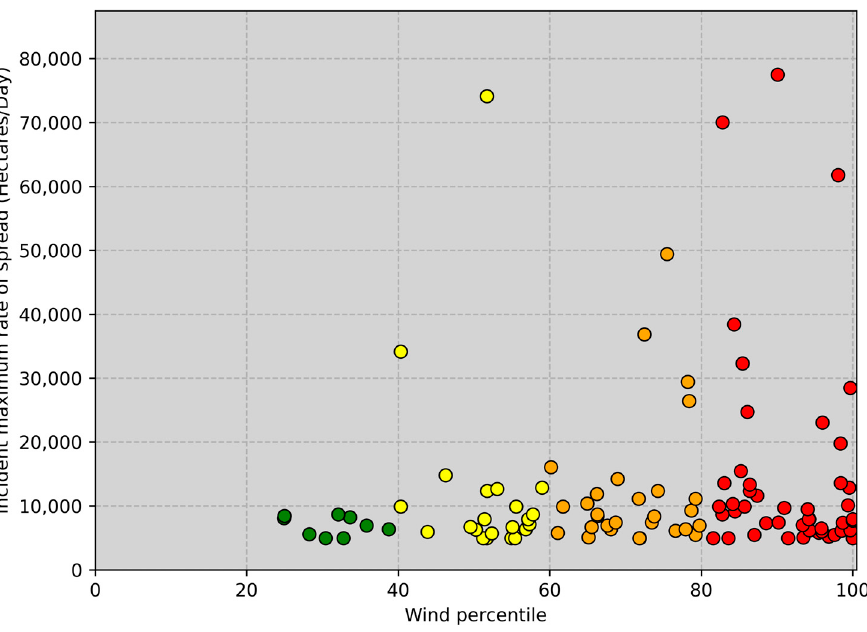
Figure 4. Wind speed percentiles for large incidents exceeding the statewide ROS breakpoint in OK, 1999–2014. Color scheme same as for Figure 3.